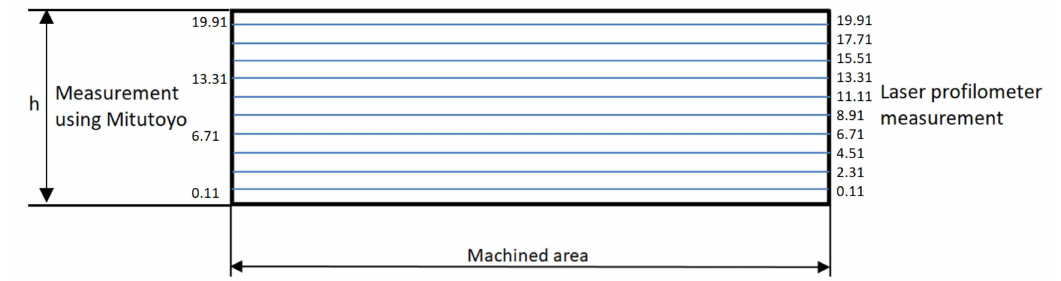
Figure 8. Sites measured by contactless method.